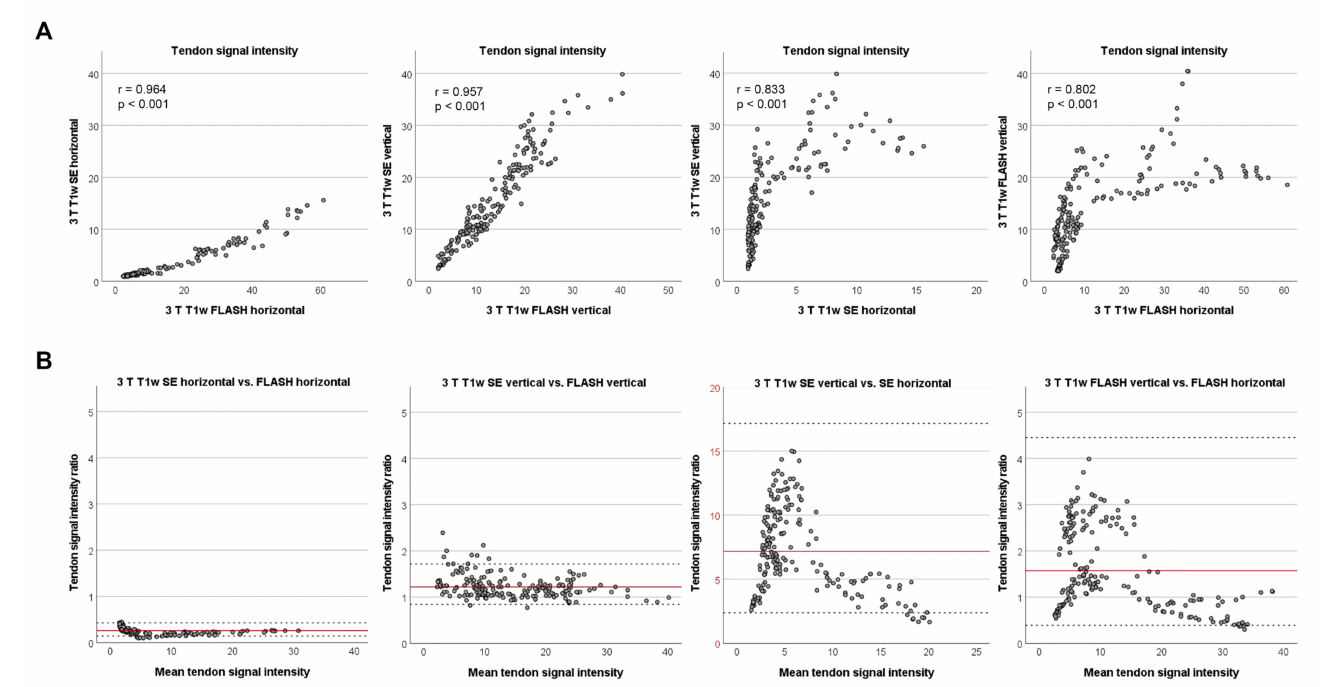
Figure 4. Relationship between tendon signal intensities in the different T1w high-field sequences. ( A ) The dot plots display the tendon signal intensity in the high-field (3 T) SE versus the FLASH sequences in the same orientation, as well as the tendon signal intensities in the SE and FLASH sequences in vertical versus horizontal orientation. Correlations between the different T1w high-field sequences in the same orientation were stronger and the relationship more linear than those between the same type of sequence in different orientations. ( B ) The Bland–Altman plots demonstrate that the high-field SE sequence in horizontal orientation had consistently lower signal intensities than the horizontal FLASH sequence, and that the vertical sequences had a higher signal intensity than their corresponding horizontal sequence (note the different scale in the SE sequence plot). The lower range of variation in the ratio of signal intensities between sequences in the same orientation underlines their better agreement. Data were obtained from n = 195 matched